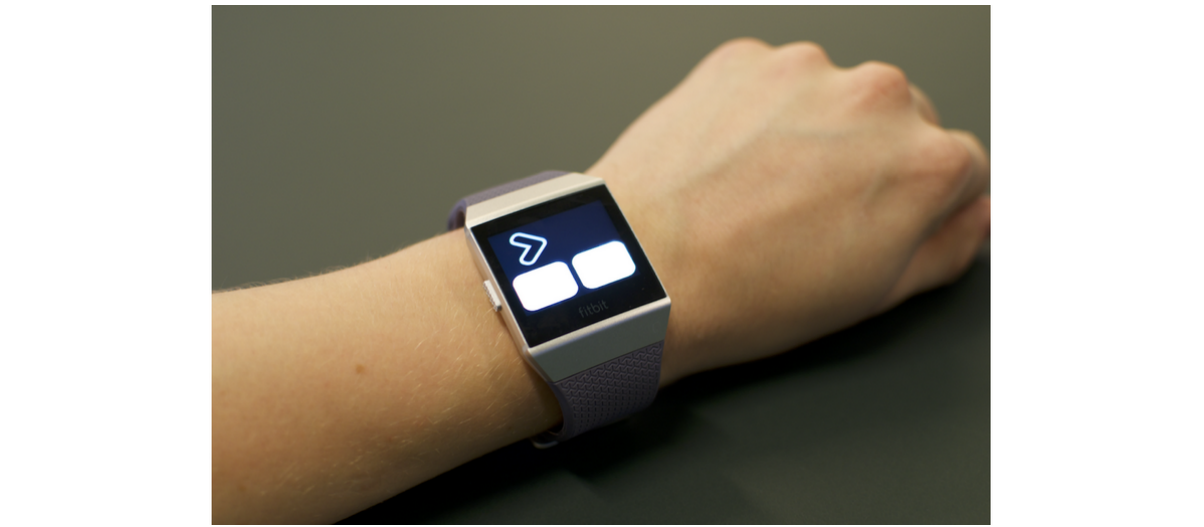
Figure 1. A sample test taken from the UbiCAT (Ubiquitous Cognitive Assessment Tool) Arrow test. The stimuli is the rightward arrow and the app buttons on both sides capture the direction of the arrow.